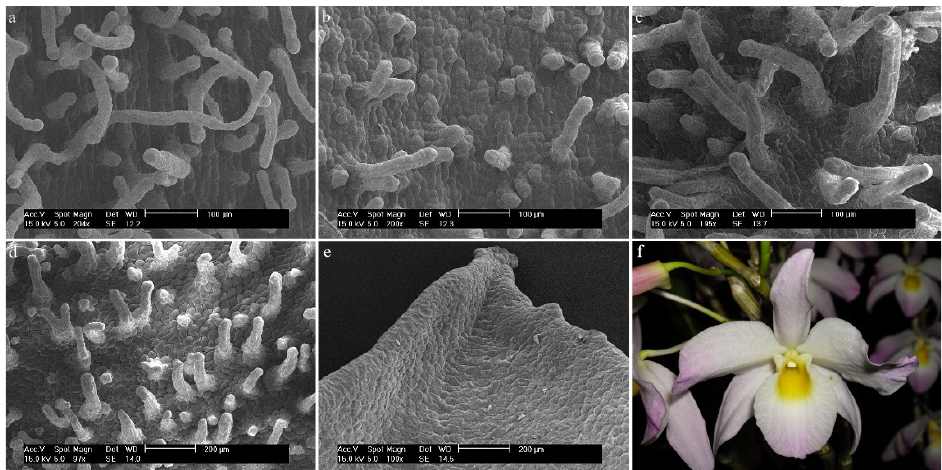
Figure 11. Dendrobium regium Prain: ( a ) trichomes of the hypochile part of the labellum; ( b ) trichomes of the final part of the hypochile of labellum/initial part of the mesochile of the labellum; ( c ) trichomes of the mesochile part of the labellum; ( d ) trichomes of the margin of the mesochile part of the labellum; ( e ) the epichile part of the labellum; ( f ) flower (photo by John Varigos).